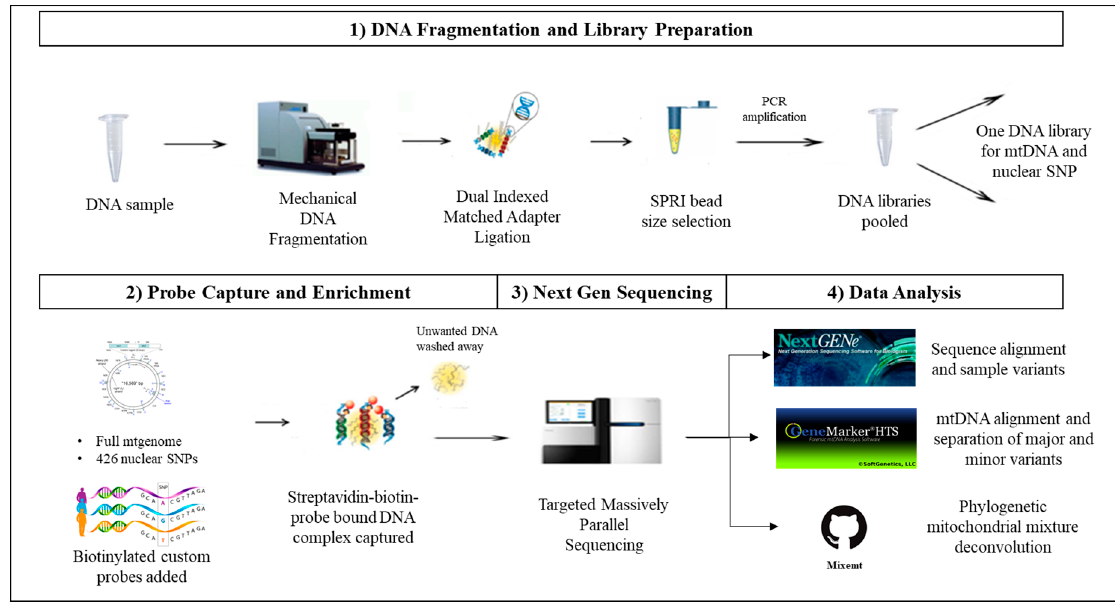
Figure 1. Novel probe capture next generation sequencing (NGS) assay for sequencing mitochondrial (mt) and nuclear DNA. To circumvent choosing between mitochondrial and nuclear analysis of degraded or limited forensic DNA samples, a capture enrichment based library preparation method can be implemented. In this method: ( 1 ) DNA libraries are prepared by fragmenting the DNA samples using Covaris ® M220 Focused-ultrasonicator TM (Covaris). DNA fragments are ligated with dual-index adapters, and the amplified DNA libraries are size-selected using SPRIselect ® beads (Beckman Coulter Life Sciences, Indianapolis, IN, USA). ( 2 ) Shotgun libraries are enriched using a DNA probe based method of targeted capture enrichment for the whole mtgenome and eight categories of nuclear single nucleotide polymorphism SNP markers (426 SNPs). ( 3 ) The enriched samples are then sequenced on a NGS platform. ( 4 ) The nuclear SNP data is analyzed using NextGENe (SoftGenetics LLC, State College, PA, USA), while the mitochondrial data is analyzed using NextGENe, GeneMarker ® HTS (SoftGenetics LLC), and Mixemt [50].